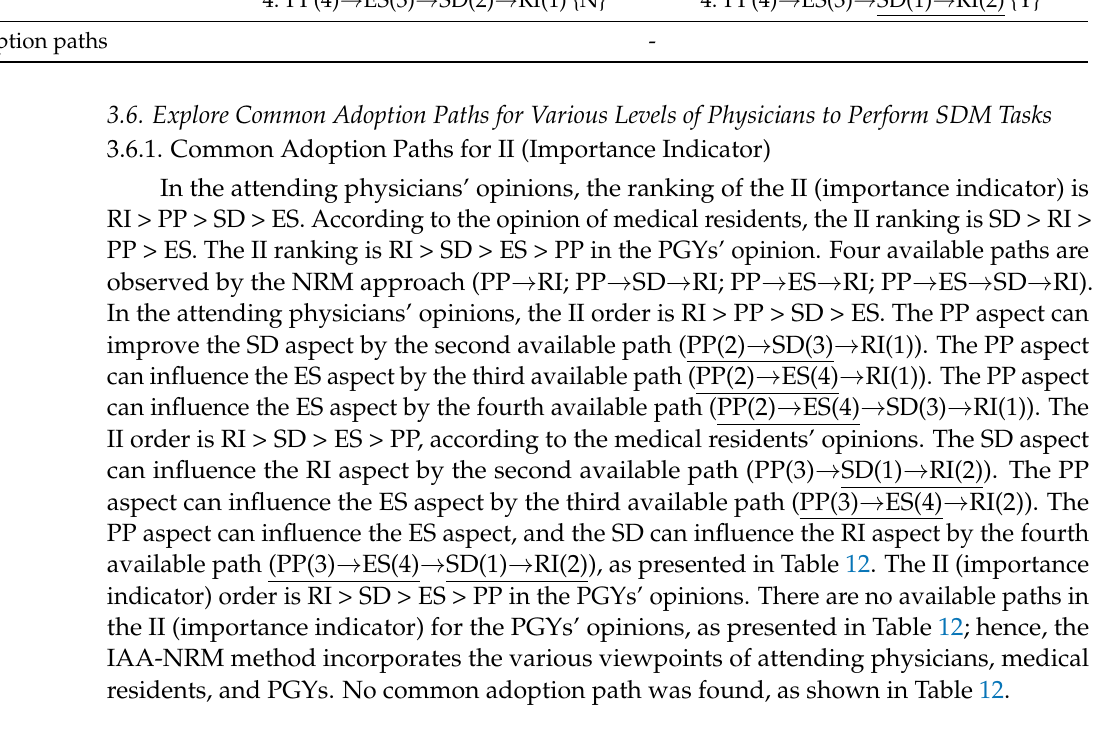
Table 12. Common adoption paths for II (importance